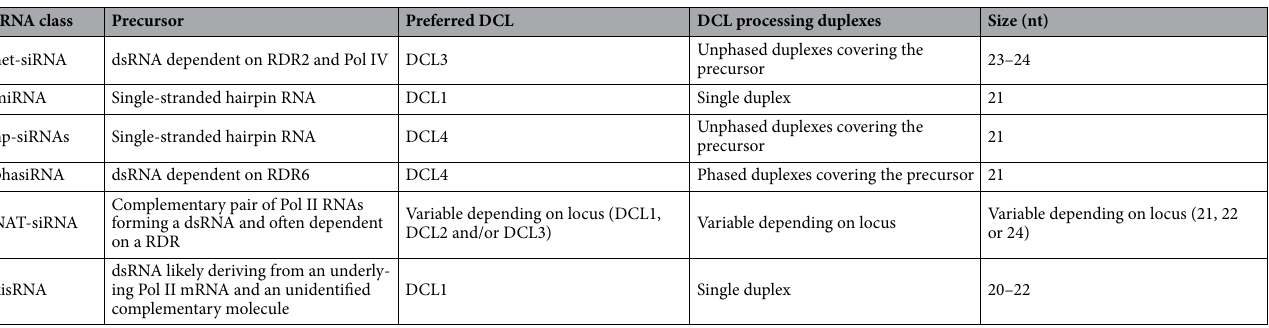
Table 1. A comparison of xisRNA properties against main documented classes of endogenous plant non- coding